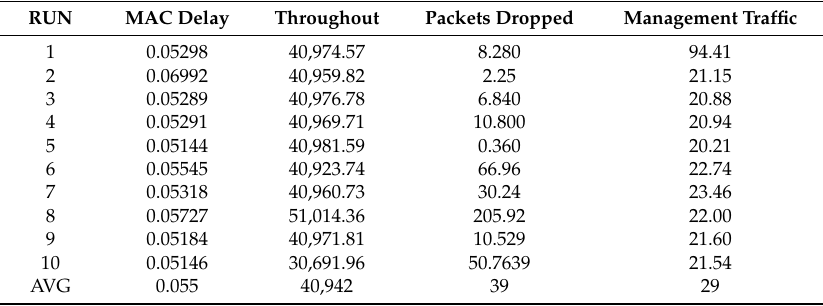
Table 13. Patient Bed Scenario Counting Packets.